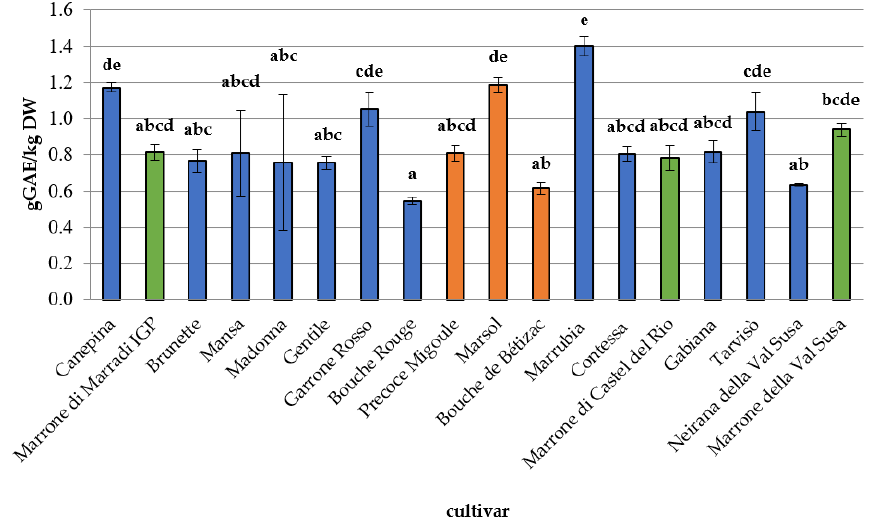
Figure 4. Total polyphenol content of the 18 chestnut cultivars. Different letters for each cultivar indicate the significant differences at p < 0.05. Blue colour: Sweet chestnut—SC; orange colour: Euro-Japanese hybrid—EH; green colour: Marrone-type chestnut—MT.